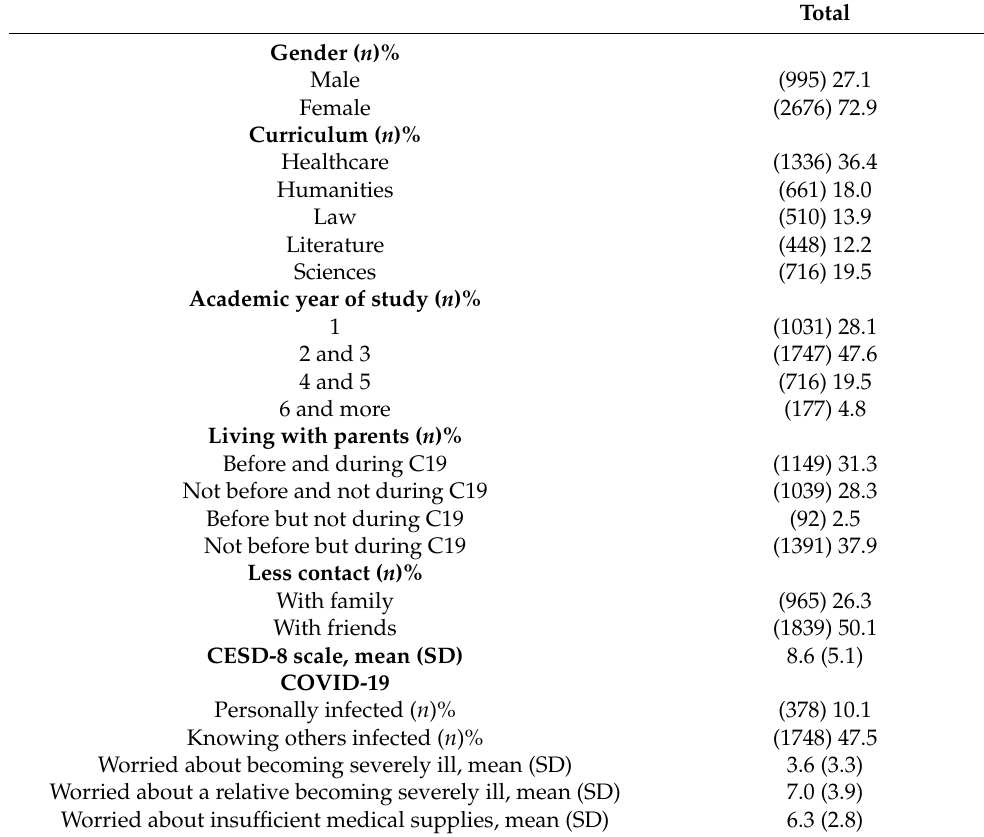
Table 1. Characteristics of university students ( n =